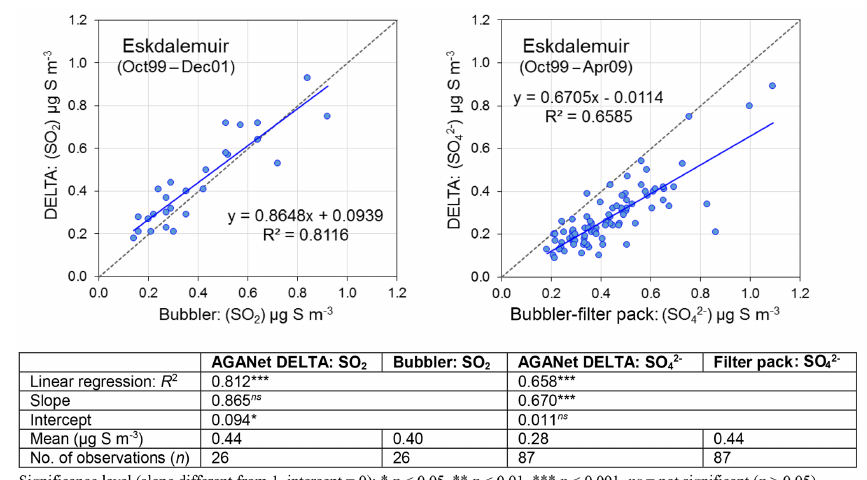
Figure 5. Comparison of gaseous SO 2 and particulate SO 2 − concentrations at the Eskdalemuir monitoring station (EMEP station 4 code = GB0002R; UK-AIR ID = UKA00130) measured under the Acid Deposition Monitoring Program (ADMN, Hayman et al., 2007) with the corresponding gas and aerosol from the UK Acid Gases and Aerosol network (AGANet). ADMN values (EMEP, 2017b) are means of daily measurements for SO 2 by the bubbler method and SO 2 − by the EMEP filter pack method (Hayman et al., 2007), matched to the 4 AGANet sampling periods (monthly). Bubbler and filter pack measurements at Eskdalemuir terminated in December 2001 and April 2009, respectively. A summary of the regression analyses is provided in the table below the